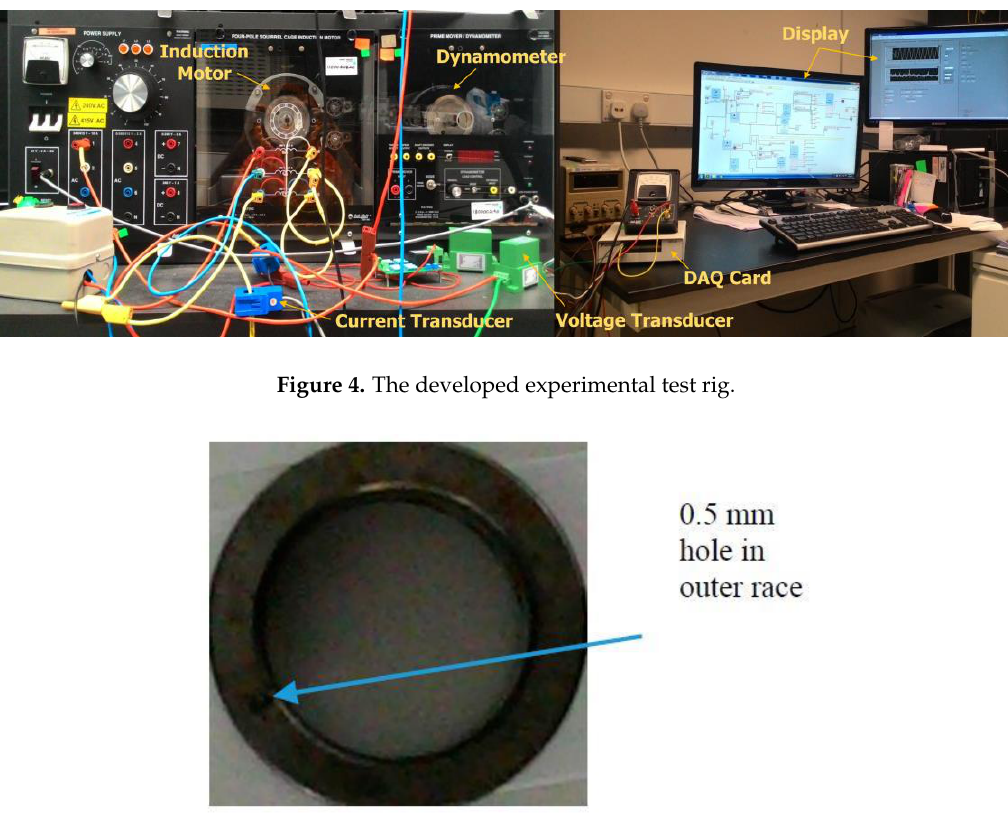
Figure 5. Bearing outer race defect of size 0.5 mm.